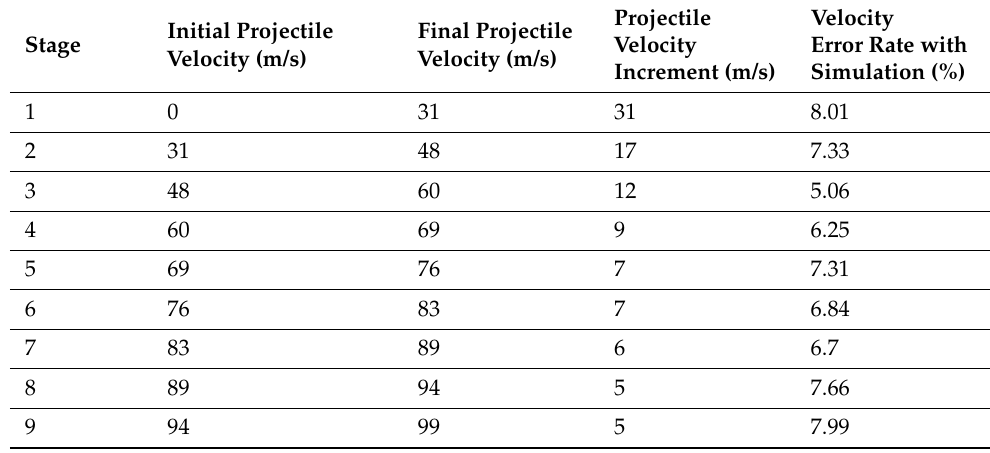
Table 4. Error and measurement range of the velocity measuring equipment. Table 5. Results of the projectile velocity measurements of the nine-stage coil